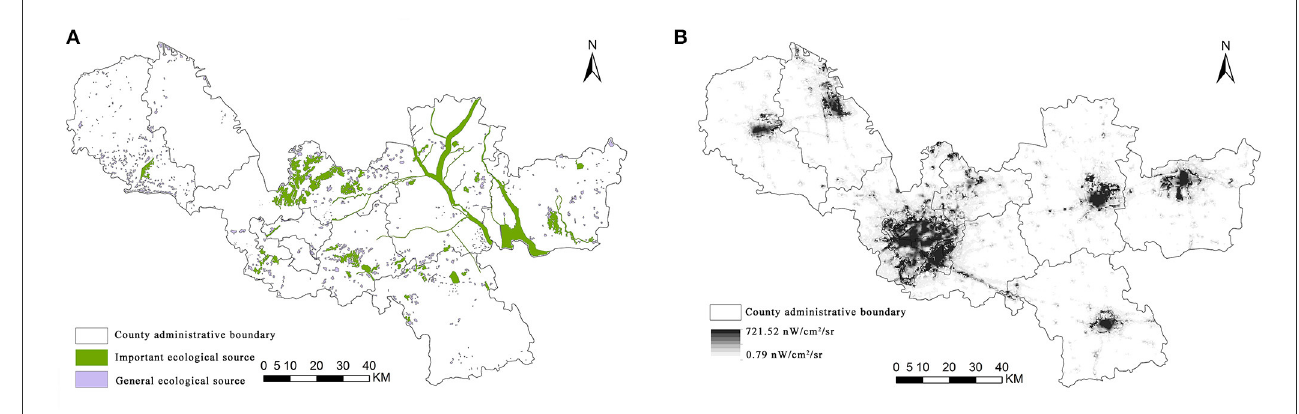
FIGURE5 Spatial distribution of ecological sources (A) and resistance surface (B) in